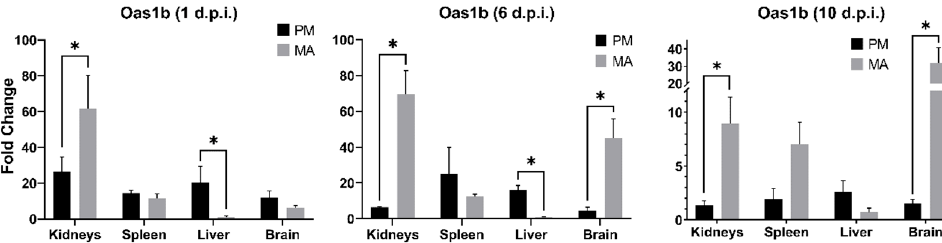
Figure 4. Expression levels of Oas1b in Peromyscus maniculatus (PM) and Mesocricetus auratus (MA) tissues as detected by RT-qPCR. Each timepoint reflects the mean relative expression levels from infected replicates ( n = 3) of each species. Bars with asterisks (*) denote a significant difference in relative expression between species (uncorrected for multiple tests).